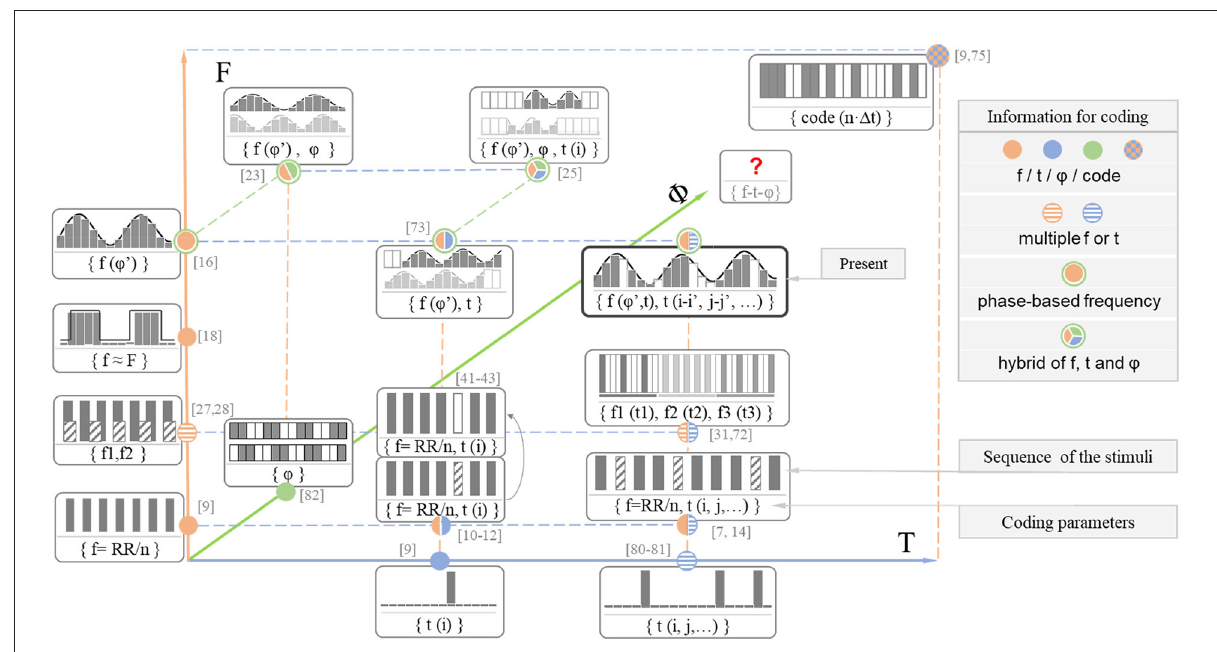
FIGURE13 A comparison of coding methods on the current VEP BCI paradigm based on time, frequency, phase, and code information.